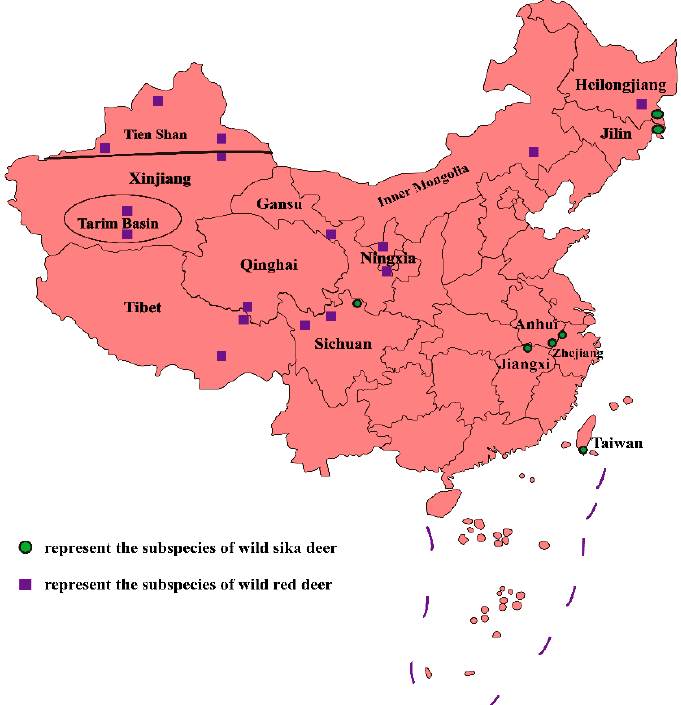
Figure 1. Distribution landscape of wild velvet deer in China. Green circles represent the distribution of subspecies of wild sika deer and purple squares represent the distribution of subspecies of wild red deer.